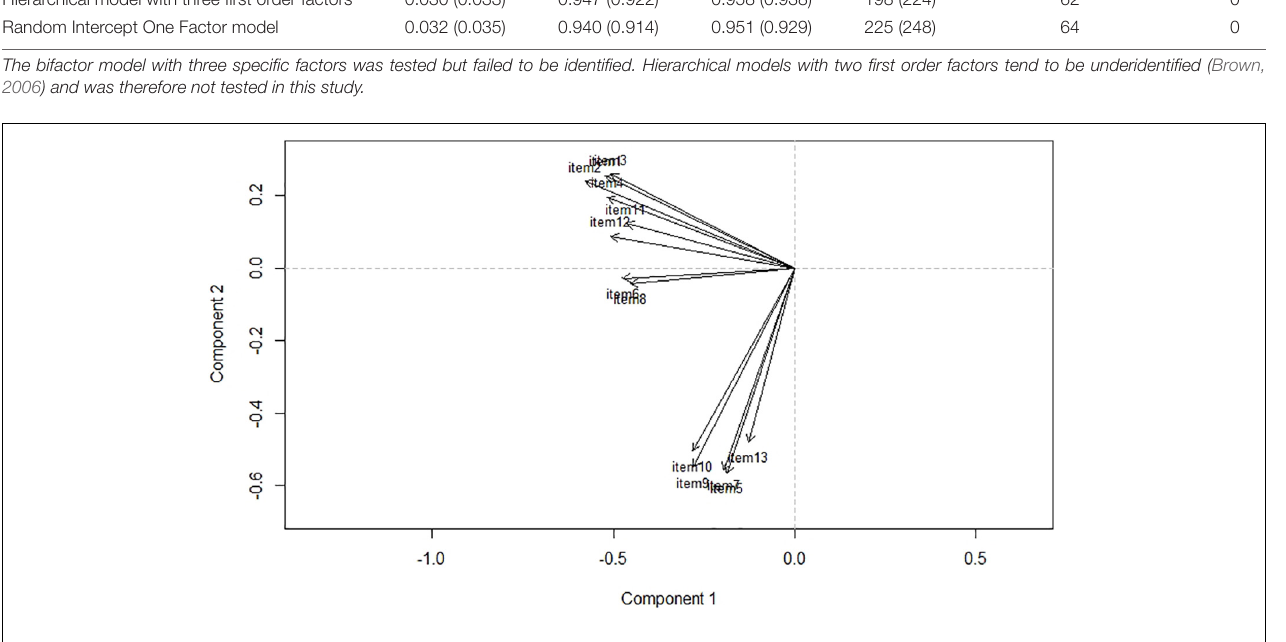
FIGURE 3 | CATPCA loadings